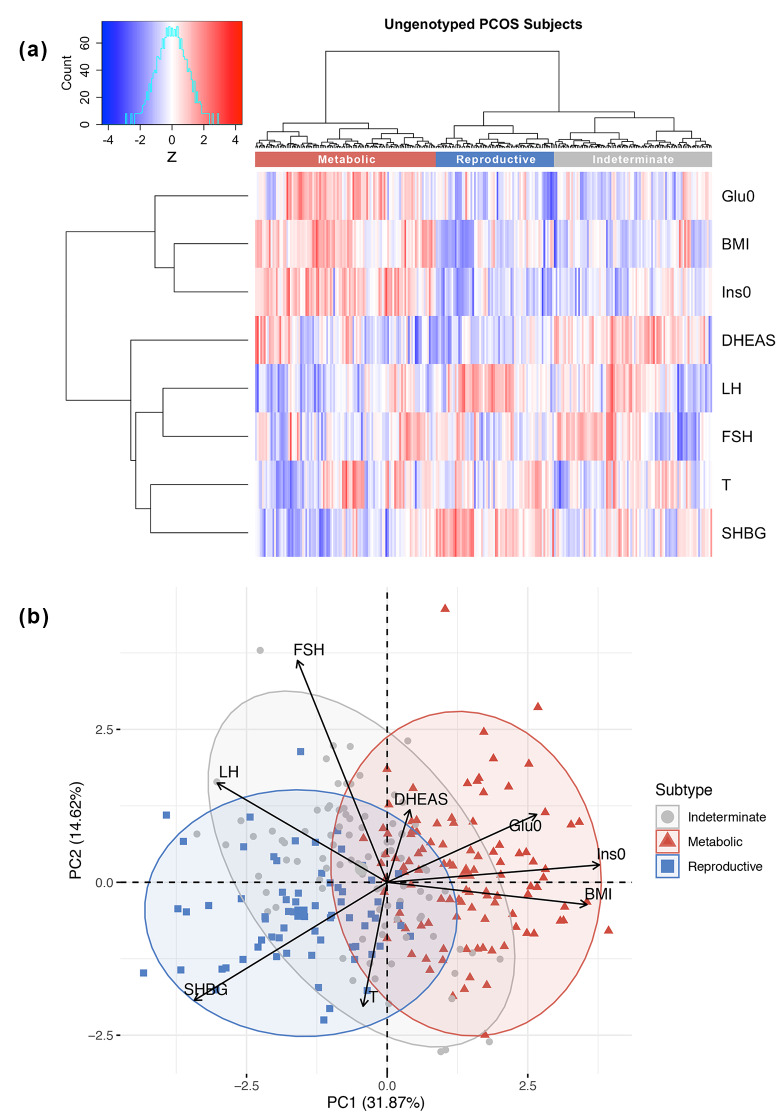
Clustering of ungenotyped PCOS clustering cohort. (a) Hierarchical clustering of 263 ungenotyped PCOS cases according to adjusted quantitative traits replicate reproductive (blue), metabolic (red), and indeterminate (gray) clusters. Heatmap colors correspond to trait z-scores. (b) PCA plot of ungenotyped PCOS cases replicate results from genotyped cases. BMI, body mass index; DHEAS, dehydroepiandrosterone sulfate; FSH, follicle-stimulating hormone; Glu0, fasting glucose; Ins0, fasting insulin; LH, luteinizing hormone; PC, principal component; PCA, principal component analysis; PCOS, polycystic ovary syndrome; SHBG, sex hormone binding globulin; T, testosterone.